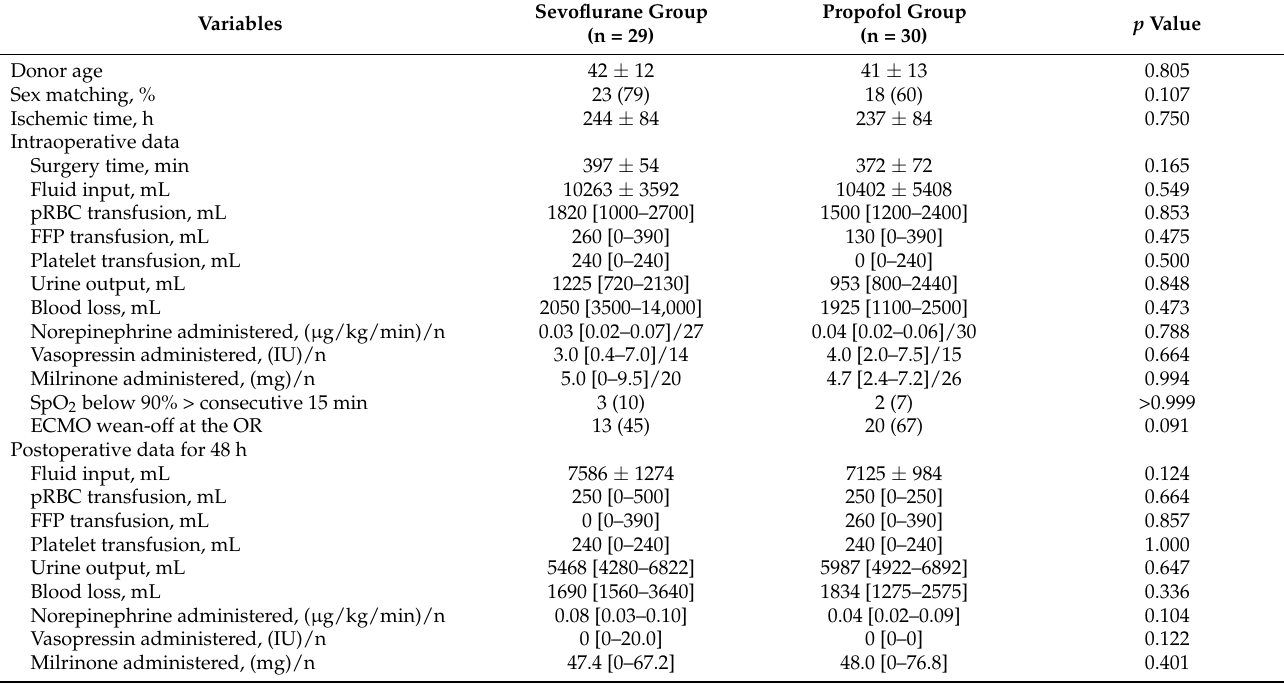
Table 2. Perioperative